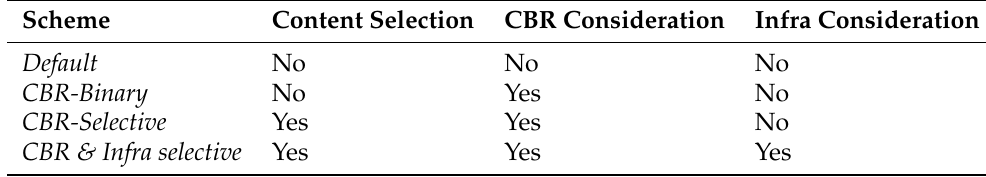
Table 2. CPM generation and content selection